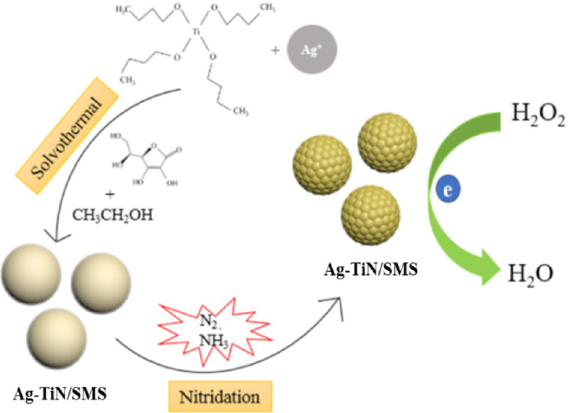
Figure 1. Scheme illustration of the synthesis procedure of fabrication of Ag-TiN submicroshperes for H 2 O 2